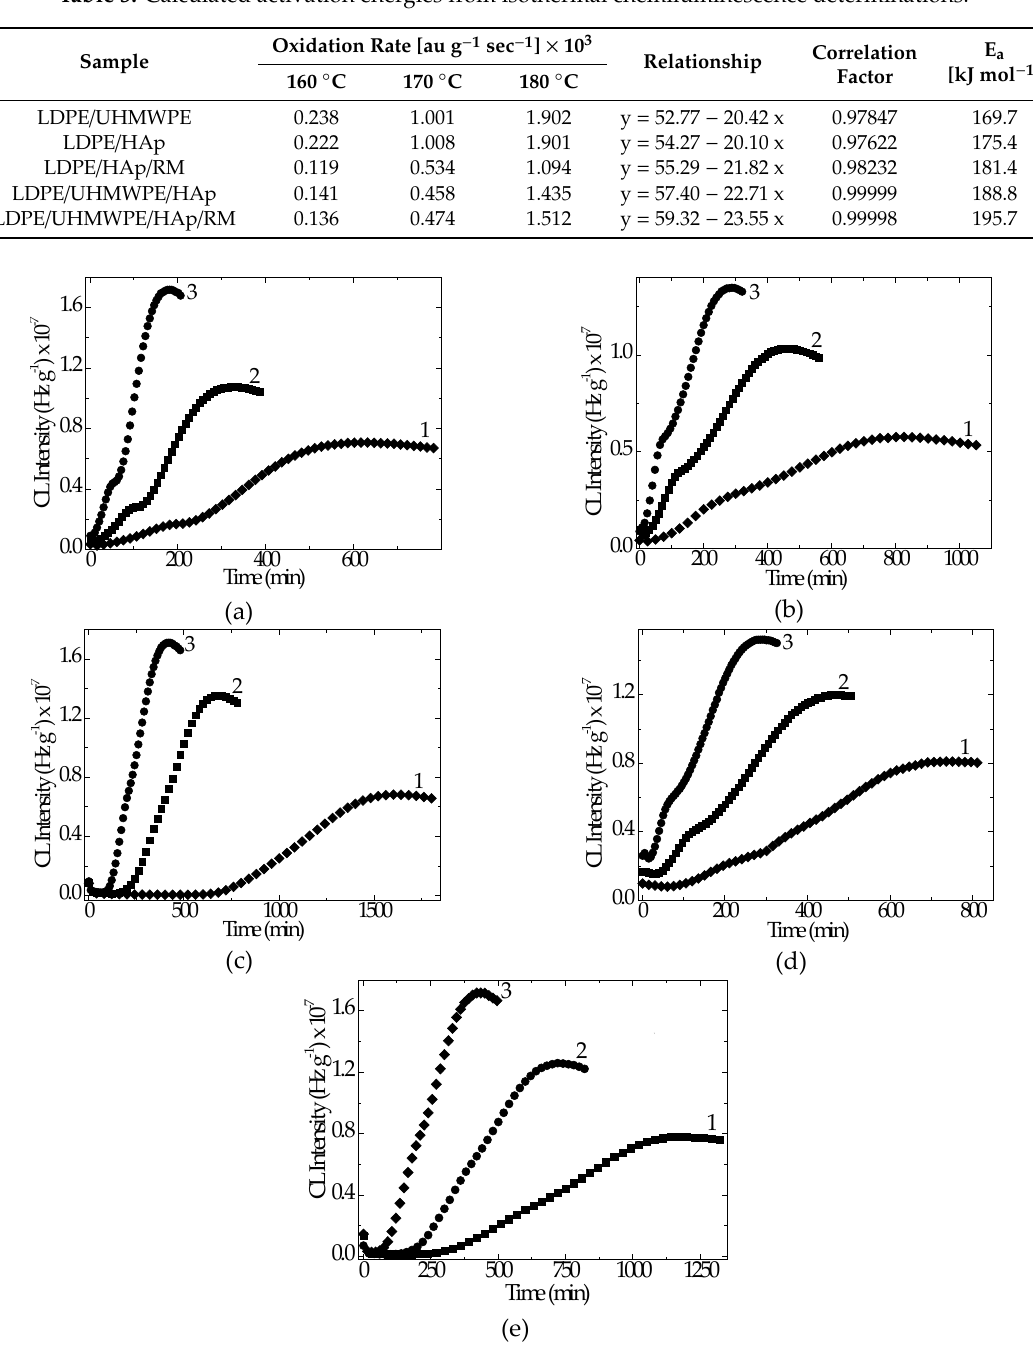
Figure 4. Isothermal chemiluminescence (CL) spectra record on studied samples. Testing temperatures: (1) 160 °C; (2) 170 °C; (3) 180 °C. ( a ) LDPE/UHMWPE, ( b ) LDPE/HAp, ( c ) LDPE/HaP/RM, ( d ) LDPE/UHMWPE/HaP, ( e ) LDPE/UHMWPE/HaP/RM.